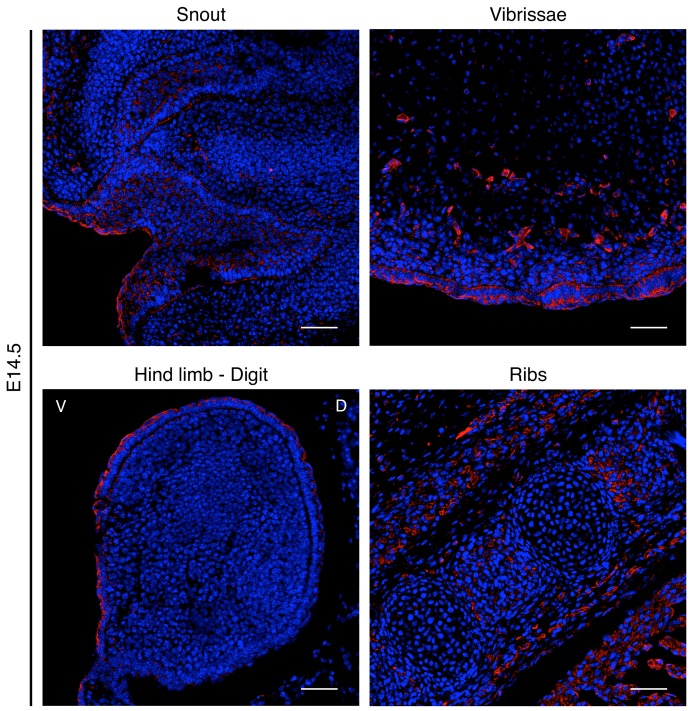
WIF1 expression pattern in E14.5 embryos.Representatives images of sagittal sections of E14.5 embryos immunostained with WIF1 (red) antibody. Scale bar is 50 μm.